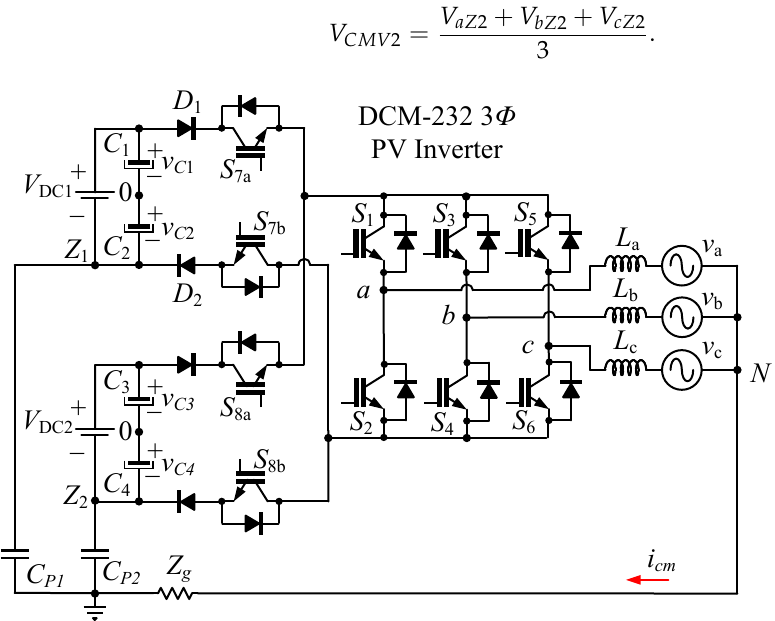
Figure 1. DCM-232 three-phase transformerless PV inverter topology.